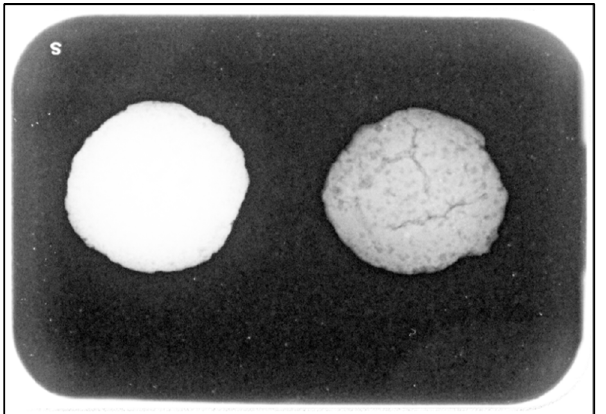
Figure 5. Radiograph of (l eft ) Sample 4 experimental pulp-capping agent and ( right ) MTA.